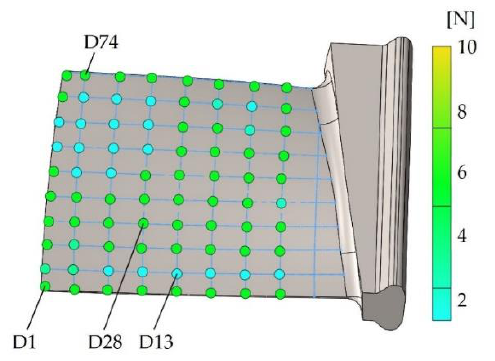
Figure 14. Graphical presentation of the pressure forces at individual points on the blade.